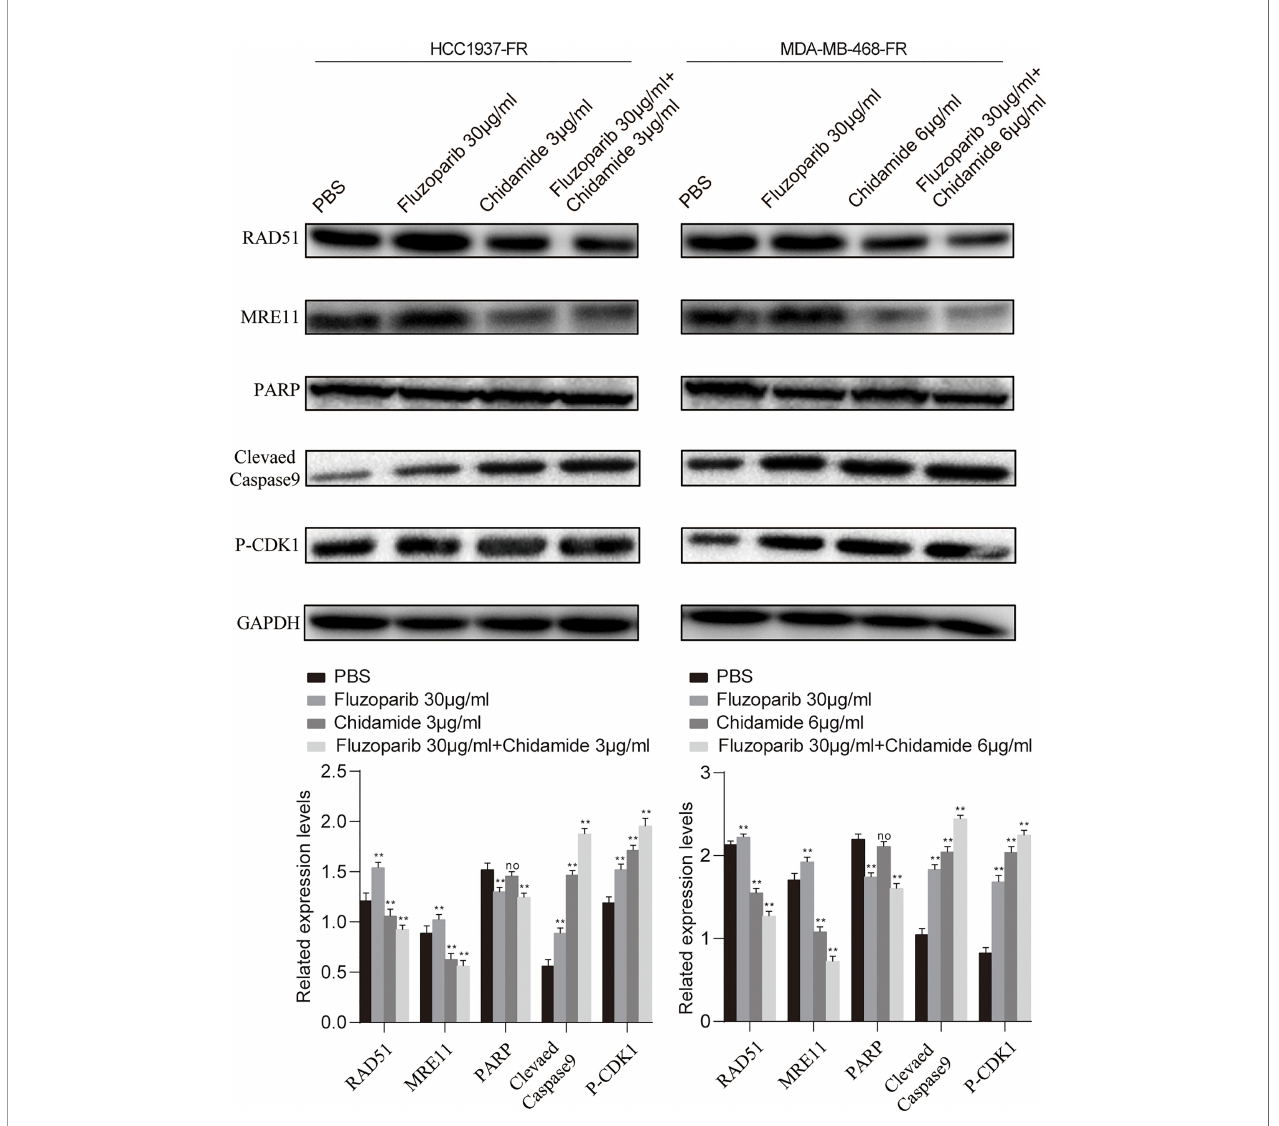
FIGURE 5 | Molecular mechanism studies of fl uzoparib-resistant HCC1937 and MDA-MB-468 cells after treatment with PBS, fl uzoparib, chidamide, or a combination treatment ( fl uzoparib + chidamide). Immunoblot analysis of RAD51, MRE11, PARP, BCL-XL, and P-CDK1 and quantitative analysis. Data represent the mean ± SD of three independent experiments. ** p < 0.05 compared with the PBS group. No, no signi fi cance. **p <